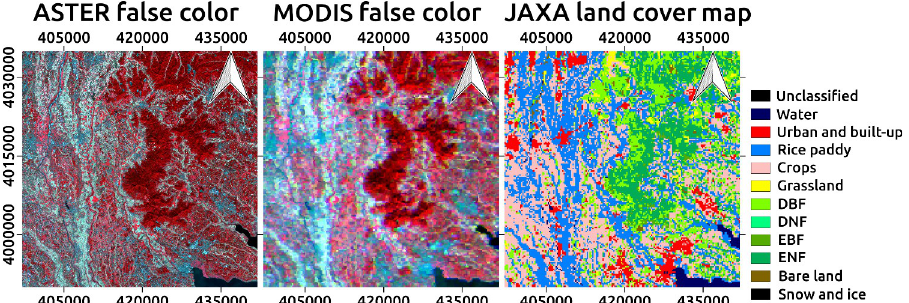
Fig 4. Reference satellite data and land cover map for the study site. (Left) False color image taken by ASTER (2001/ 09/24), (center) that taken by MODIS, and (right) JAXA land cover map degraded to 250-m resolution. All images have a UTM 54 projection with a WGS84 ellipsoid. Land cover category abbreviations: DBF, deciduous broadleaf forest; DNF, deciduous needleleaf forest; EBF, evergreen broadleaf forest; ENF, evergreen needleleaf forest.